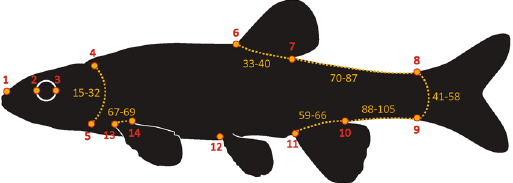
Figure 3. Positioning of landmarks (numbered in red) and semi-landmarks (numbered in